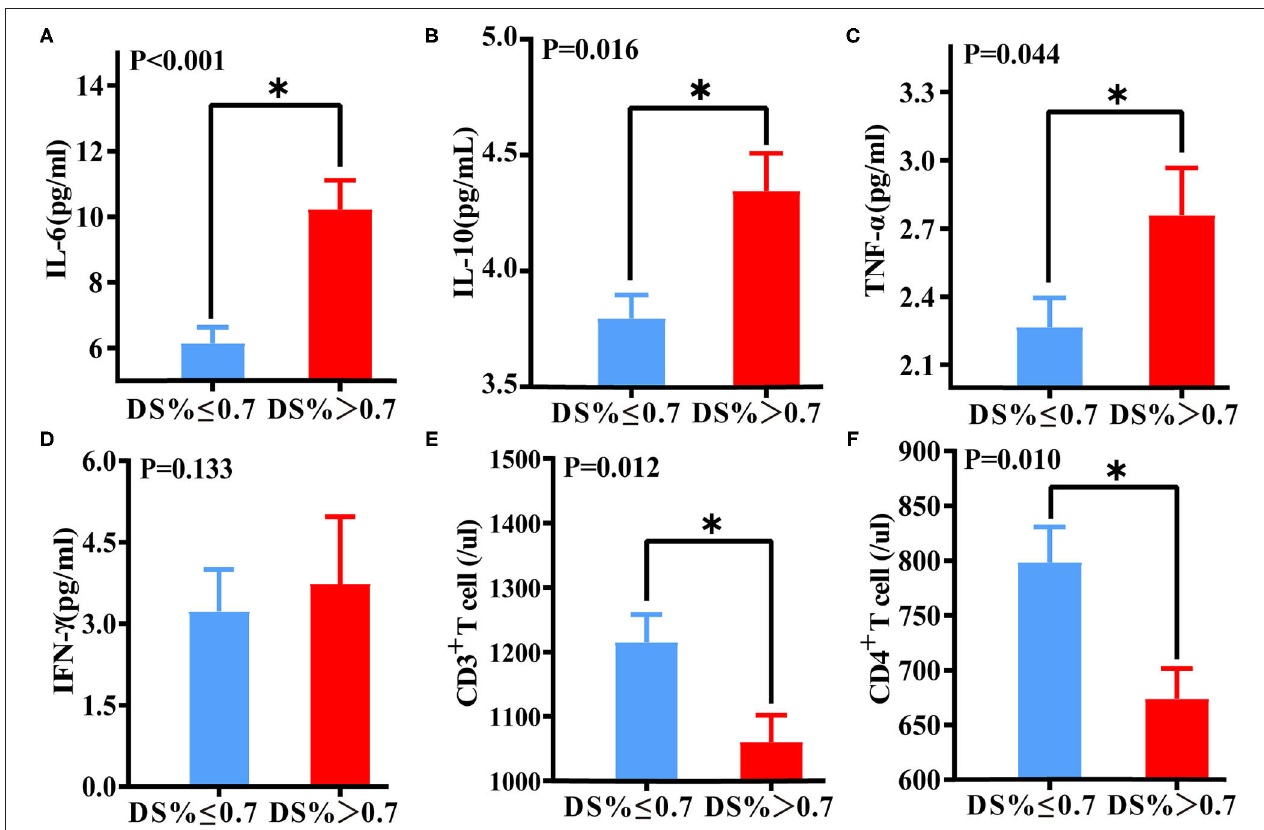
FIGURE 4 | Differences in immune function and inflammatory biomarkers between DS > 70% of the target vessel and DS ≤ 70% of the target vessel groups. Differences in IL-6 (A) , IL-10 (B) , TNF- α (C) , IFN- γ (D) , CD3 + T lymphocyte (E) , and CD4 + lymphocyte (F) levels between the DS > 70% and DS ≤ 70% groups. *A p -value < 0.05 was considered a statistically significant difference between the two